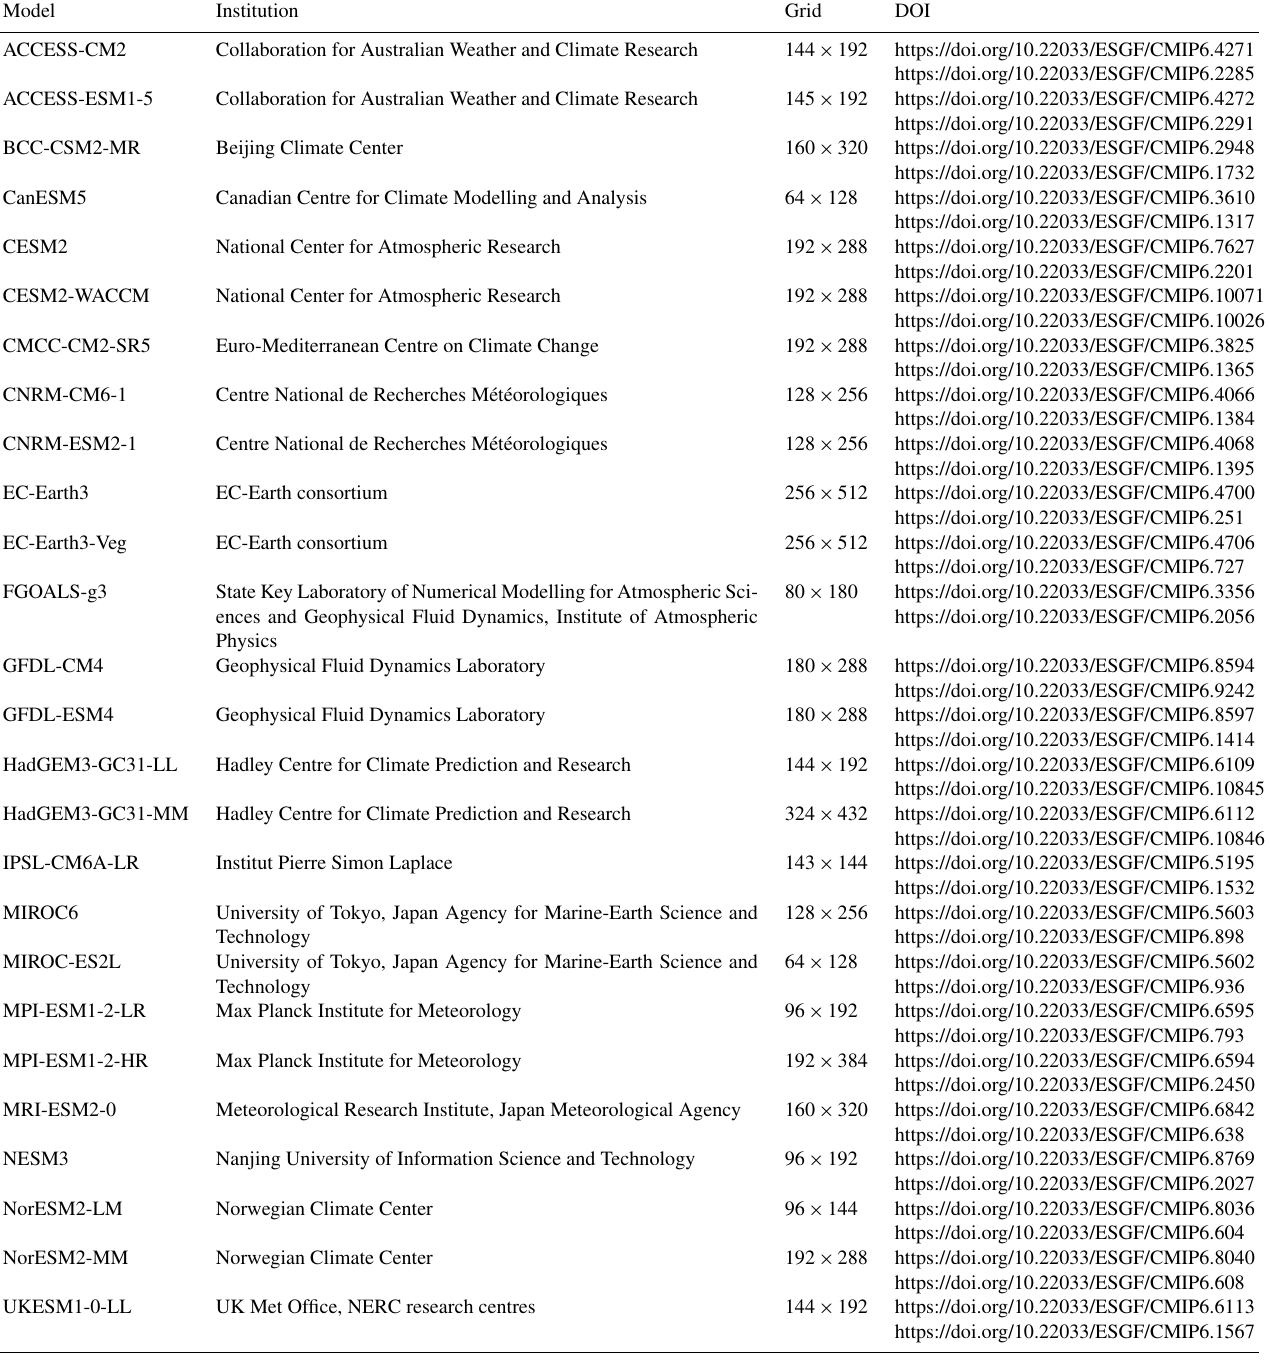
Table B1. CMIP6-models (Eyring et al., 2016) used in this project. For each of the listed models, we use the scenarios SSP126, SSP245, SSP370, and SSP585 to force BESSI, except for some missing ESM–scenario combinations. FGOALS-g3 misses SSP126, GFDL-CM4 misses SSP126 and SSP370, GFDL-ESM4 misses SSP245, HadGEM3-GC31-LL misses SSP370, HadGEM3-GC31-MM misses SSP245 and SSP370, and NESM3 misses SSP370. Data were downloaded from https://esgf-node.llnl.gov/search/cmip6/ (last access: 9 Decem- ber